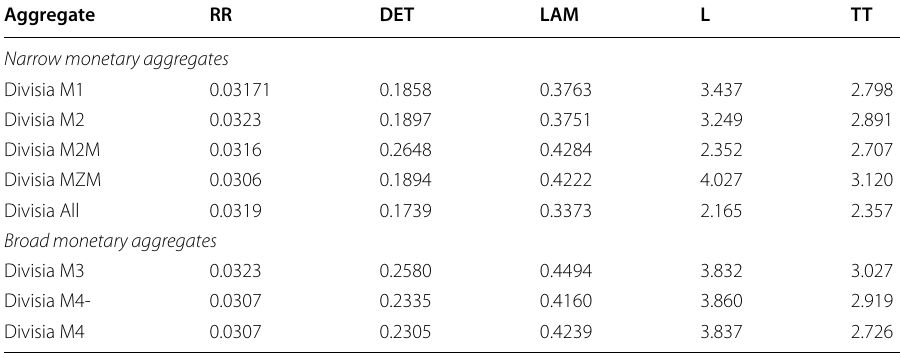
Table 4 RQA of Divisia aggregates (in log levels) Aggregate RR DET LAM L TT Narrow monetary aggregates Divisia M1 0 . 0309 0 . 9800 0 . 9974 30 . 13 18 . 92 Divisia M2 0 . 0308 0 . 9928 Divisia M2M 0 . 0302 Divisia MZM 18 . 02 Divisia All 0 . 0307 0 . 9910 0 . 9977 25 . 49 17 . 05 Broad monetary aggregates Divisia M3 0 . 0306 0 . 9914 0 . 9972 Divisia M4- 0 . 0307 Divisia M4